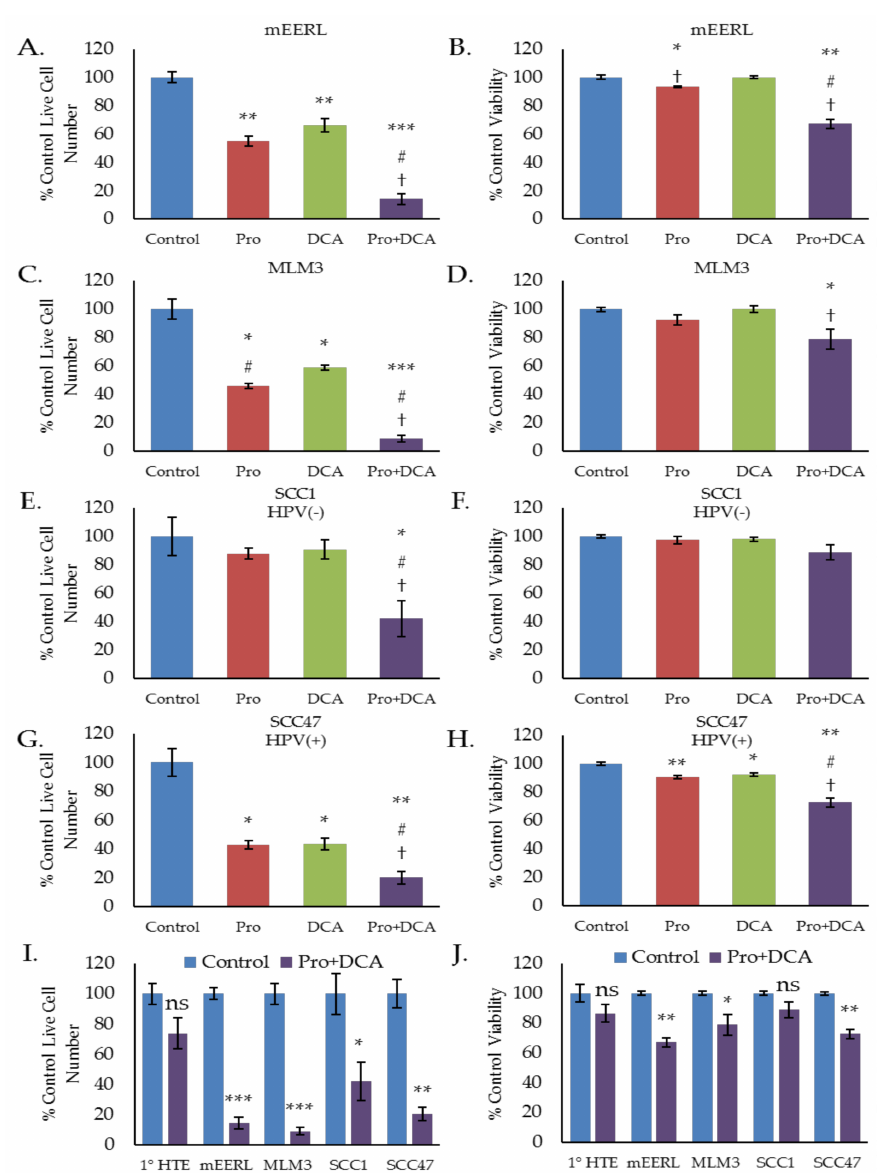
Figure 4. The combination of propranolol and DCA synergizes for robust anti-cancer activity in head and neck squamous cell carcinoma (HNSCC), but has little effect on primary tonsil epithelial cells. Cell counting ( A , C , E , G , I ) and trypan blue exclusion results ( B , D , F , H , K ) of mEERL ( A,B ), MLM3 ( C,D ), SCC1 (E,F), and SCC47 ( G,H ) treated with propranolol (40 µ M) and/or DCA (10 mM) for 48–72 h. SCC1 and SCC47 are human papillomavirus (HPV)( − ) and HPV(+) HNSCC cell lines, respectively. Comparison of Pro + DCA effects in primary human tonsil epithelial cells (1 ◦ HTE) versus HNSCC cell lines is shown in ( I ) and ( J ). Values reflects % live cell number or % viability relative to control. Each data point represents mean +/ − SEM of n = 3–4 independent biological replicates; p -values reflect t -test results (* p ≤ 0.05, ** p ≤ 0.006, *** p ≤ 0.0001 vs. control for a given cell line; # p ≤ 0.05 vs. propranolol only; † p ≤ 0.05 vs. DCA only; ns = not